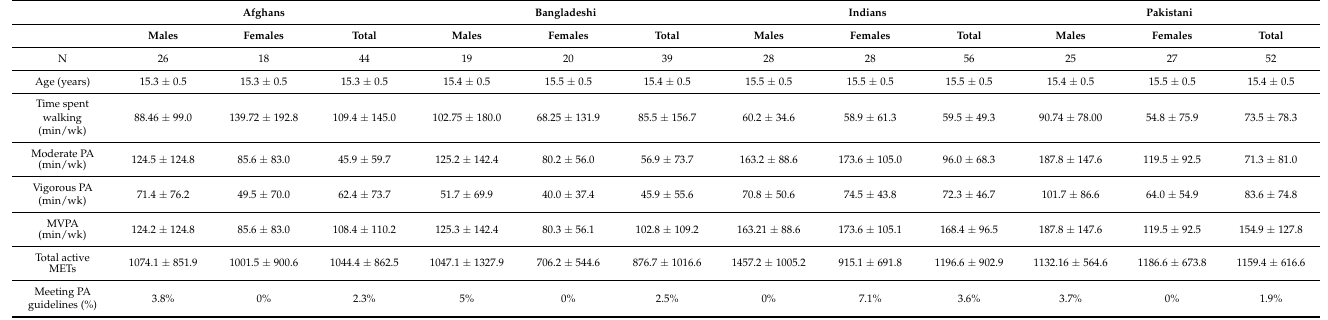
Table 1. Means and standard deviations of the main dependent variables across the four ethnic